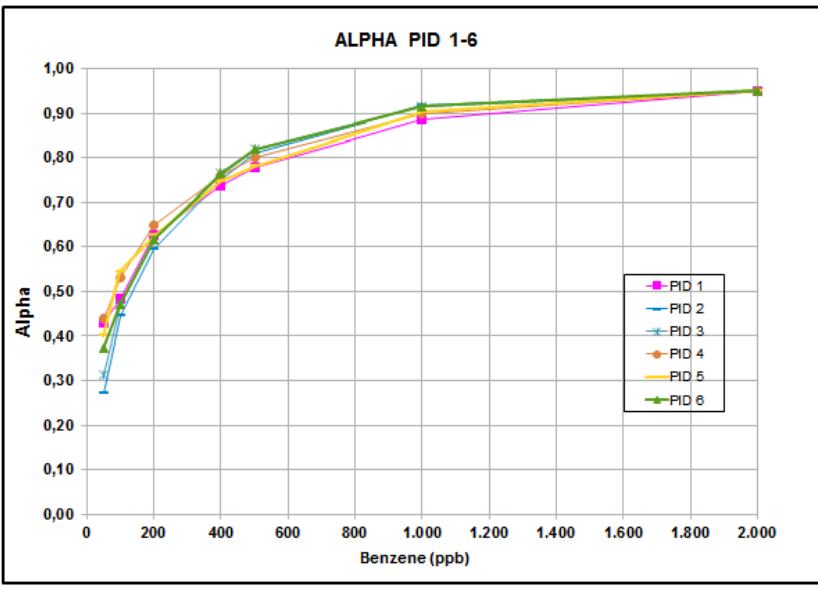
Figure 6. Measured α functions for PID 11-6.